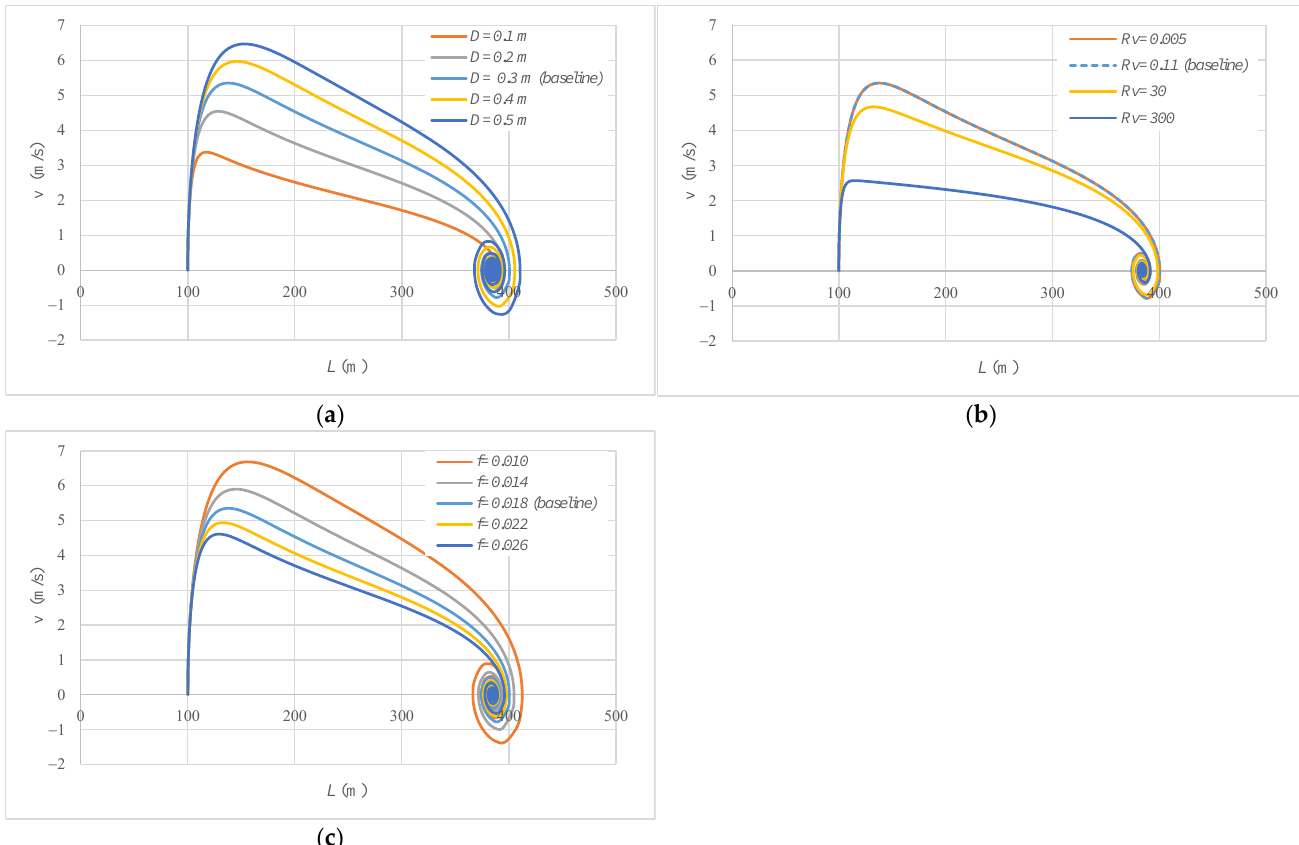
Figure 7. Sensitivity analysis for non-dependent parameters: ( a ) internal pipe diameter ( 𝐷 ); ( b ) re- sistance coefficient of a regulating valve ( 𝑅 𝑣 ); and ( c ) friction factor ( 𝑓 ) .